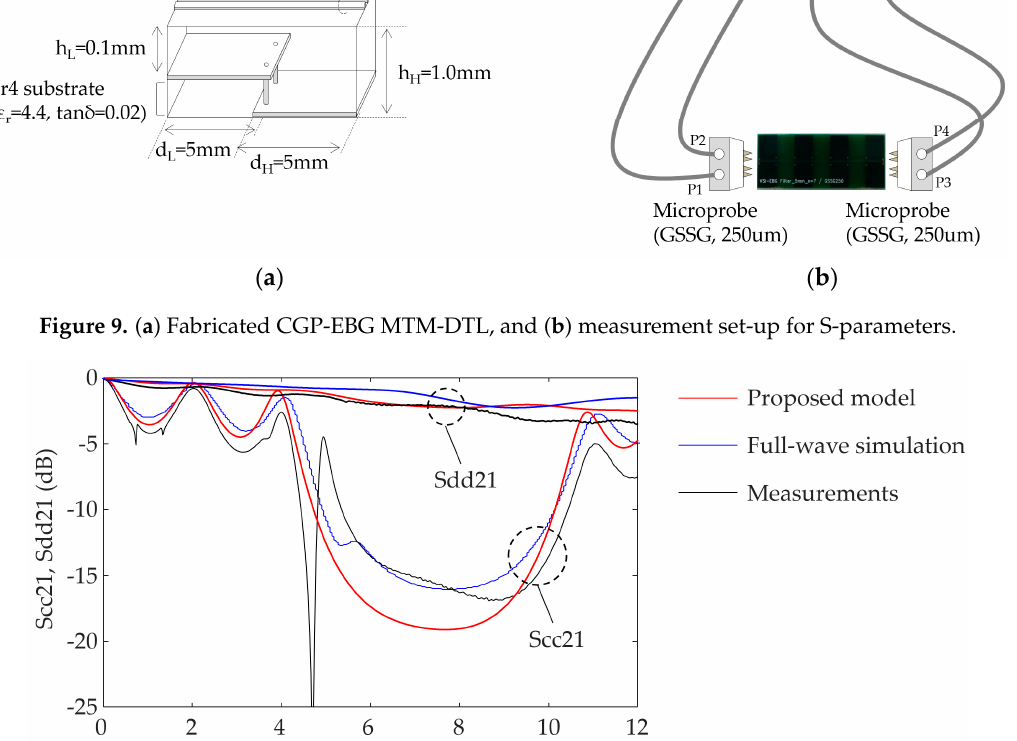
Figure 10. Comparison of S cc21 and S dd21 between proposed model, full-wave simulations, and measurements.